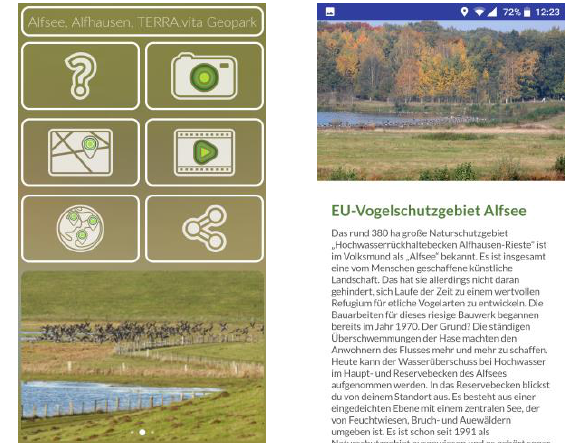
Figure 5. App main menu (left) and educational information text and graphics for the